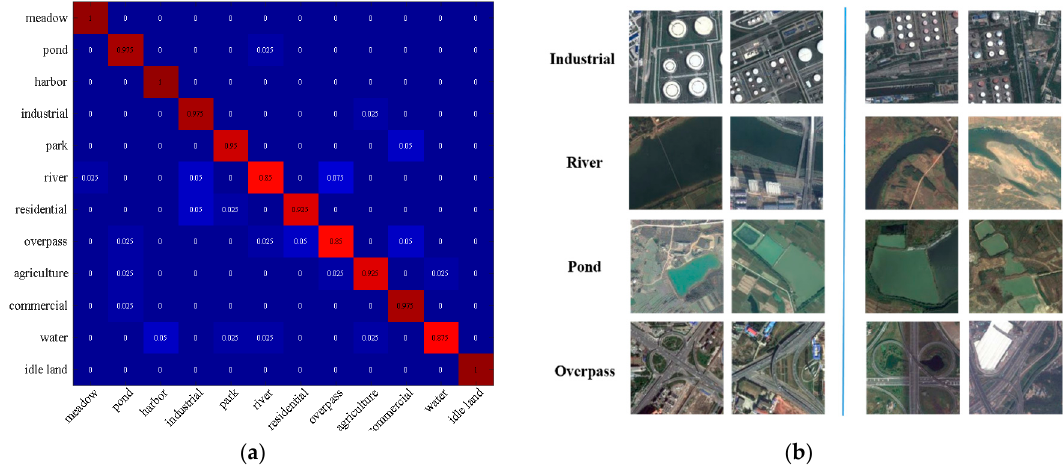
Figure 9. ( a ) The confusion matrix for the Google dataset of SIRI-WHU based on SRSCNN. ( b ) Some of the classification results of CNNV and SRSCNN with the Google dataset of SIRI-WHU. Right: correctly recognized images for both strategies. Left: images correctly recognized by SRSCNN, but incorrectly classified by CNNV.